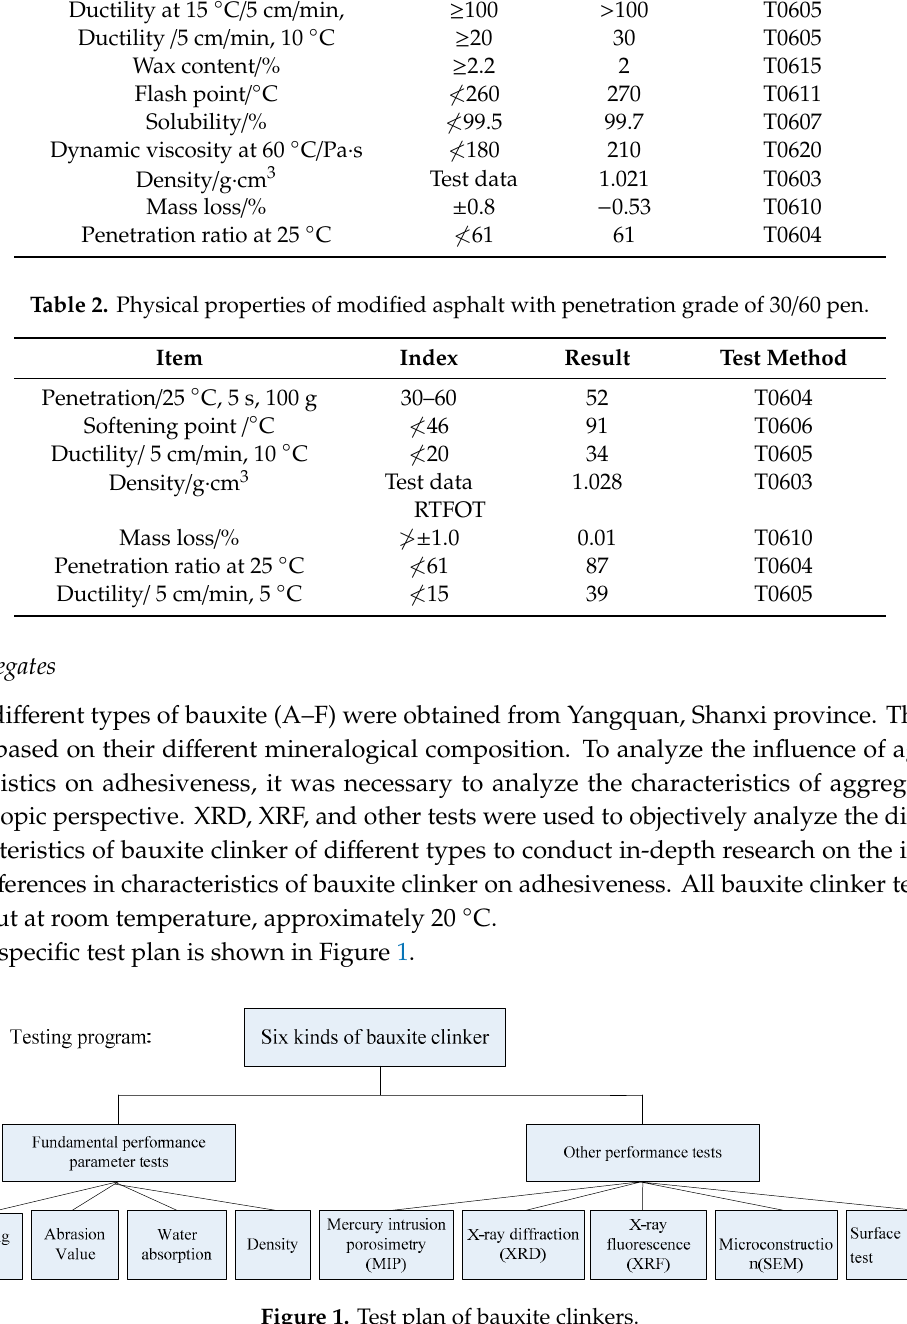
Figure 1. Test plan of bauxite clinkers.